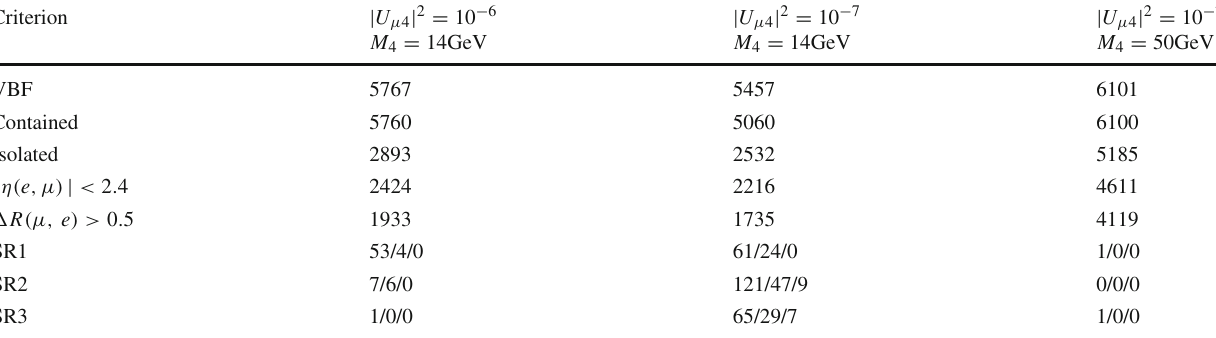
Each signal region shows three numbers, corresponding to the number of events after the loose, medium and tight cuts on the charged lepton p T . Events on each point have been generated with different seeds